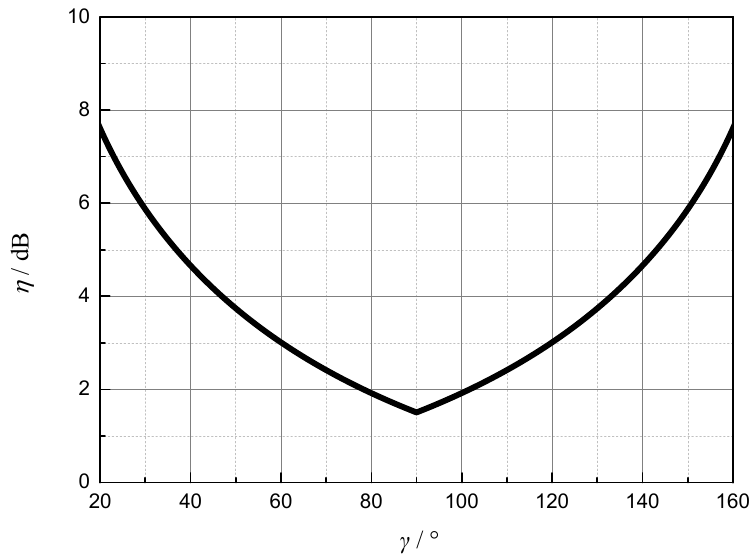
Figure 2. The deviation/uncertainty of the approximately maximum coupling with the variation of γ .